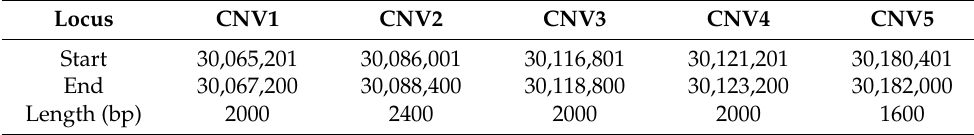
Table 2. Frequency distribution of CNVs within the Fec B gene in three different goat breeds. Breed Locus Size SBWC goat CNV1 n = 215